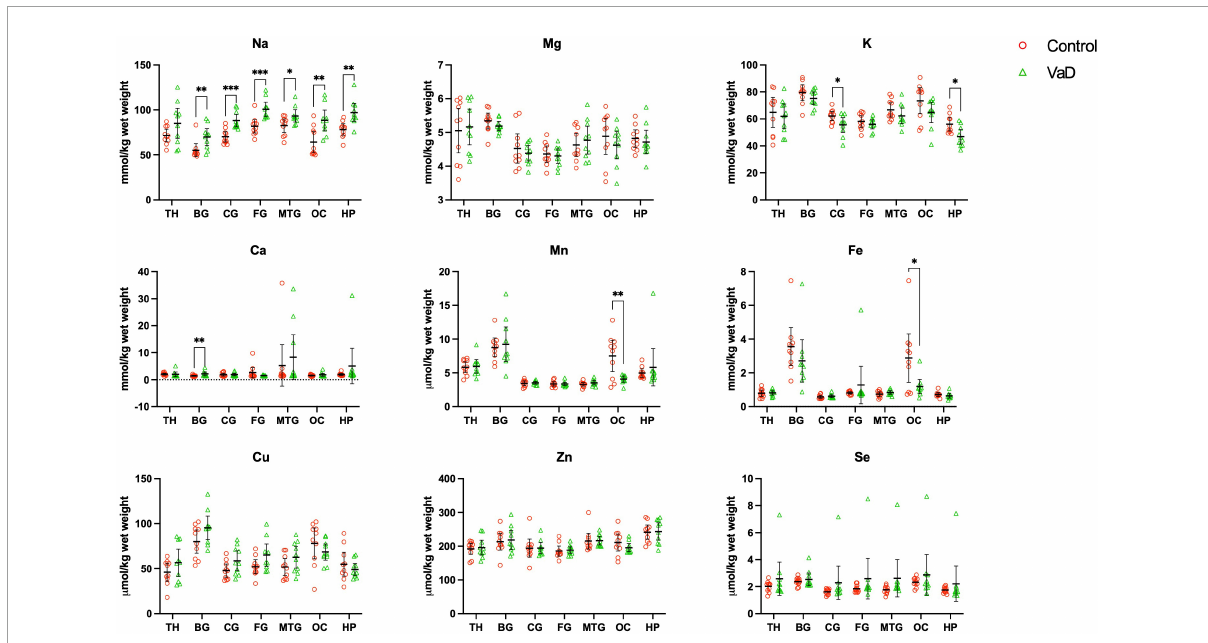
FIGURE1 Wet-weight concentrations of nine essential metals (A–I) in seven brain regions compared between control (red) and VaD (green) post-mortem tissue. Data are means ± 95% CI. TH, thalamus; BG, basal ganglia; CG, cingulate gyrus; FG, frontal gyrus; MTG, middle temporal gyrus; OC, occipital cortex; HP, hippocampus. * p < 0.05, ** p < 0.01, and *** p <